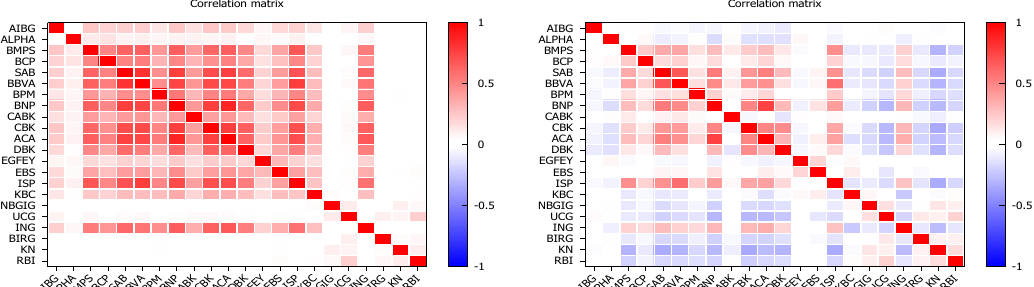
Figure A1. Cross-Correlation Matrix: ( top ) the cross-correlation matrix for raw data; and ( bottom ) for the full model residuals. Breusch–Pagan LM test of independence: F-statistic: 0.61, p -value: 0.4348. This implies there is no cross-sectional dependence among residuals.